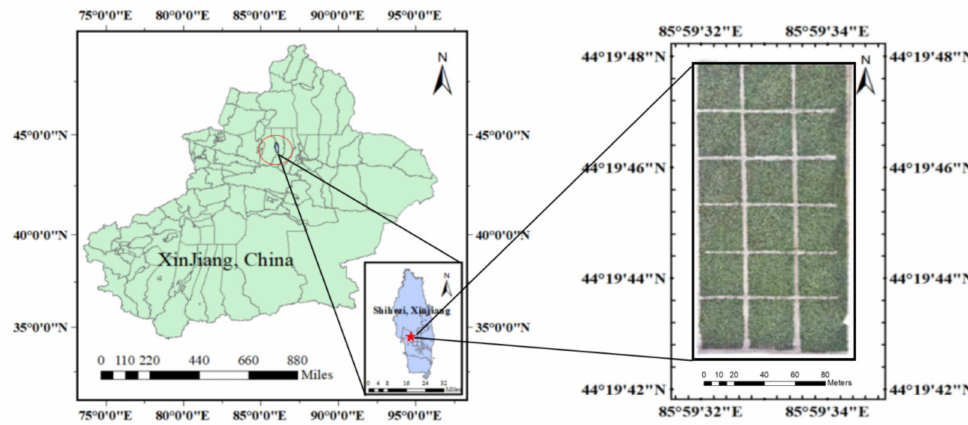
Figure 1. The experimental area.